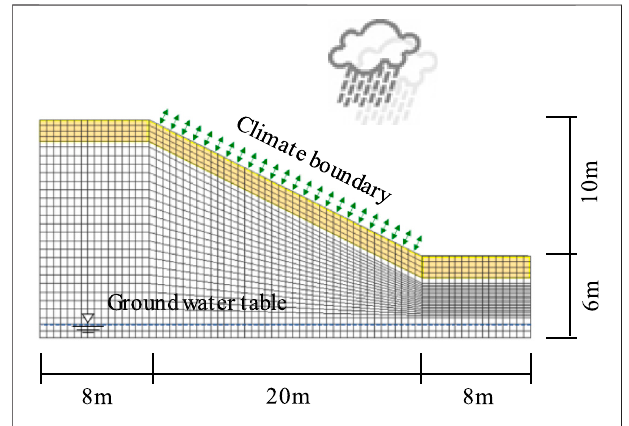
FIGURE 2 | Numerical model of a typical highway